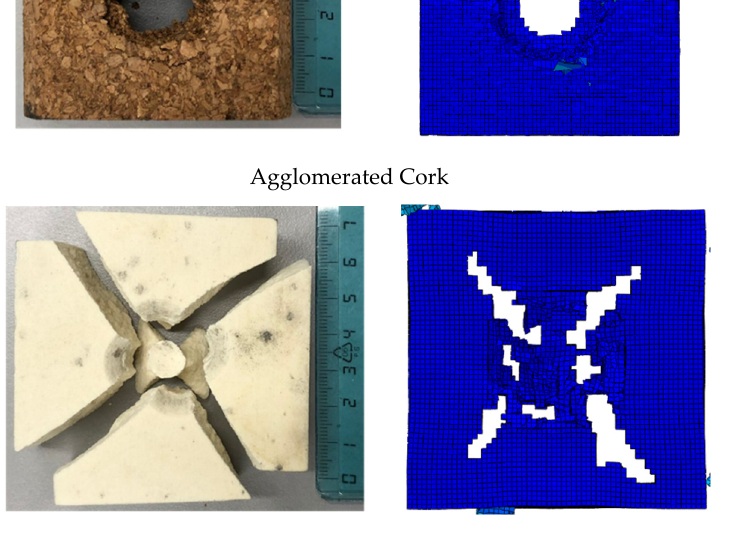
Figure 7. Comparison between experimental ( left ) and FE ( right ) damaged samples after impacts.